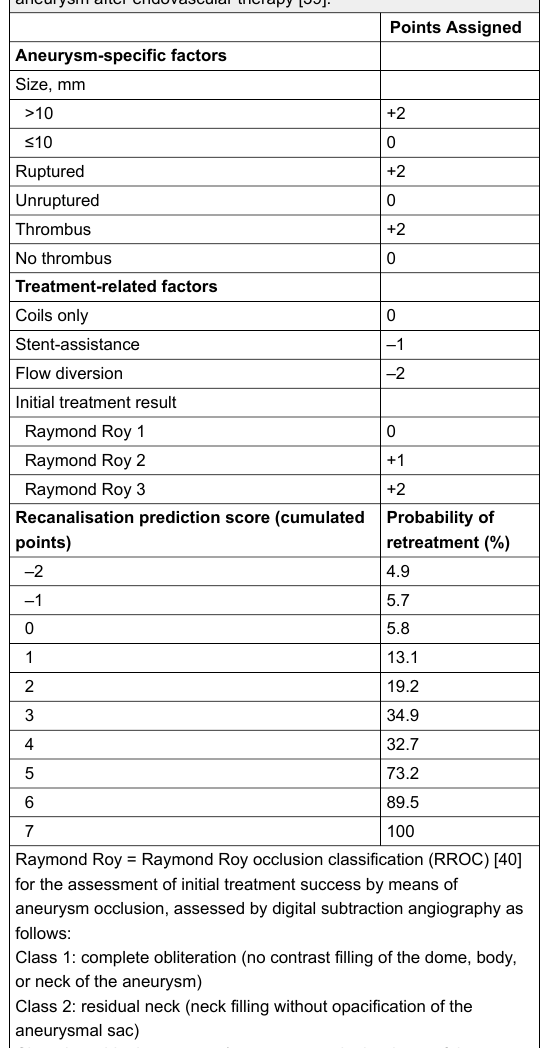
Table 3: Prediction score for recanalisation of an intracranial aneurysm after endovascular therapy [39].